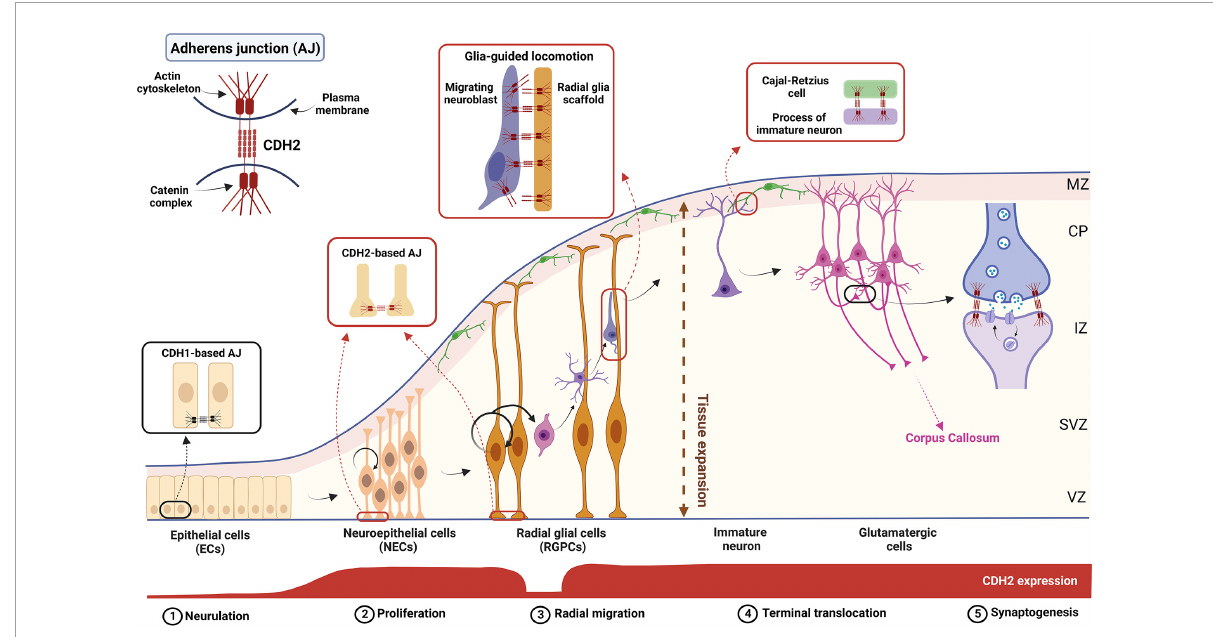
FIGURE1 The complex role of CDH2 during cortical development. Schematic diagram showing the different stages of cortical development. CDH2-based adherens junctions appear after neurulation and are present in both NECs and RGPCs. After asymmetric cell division in the ventricular zone (VZ), newborn, non-radial glia-fated daughter cells delaminate from the RGPCs and undergo radial glia-guided locomotion through the subventricular and intermediate zones (SVZ and IZ, respectively) utilizing CDH2 connections. Once the immature neuron reaches the cortical plate (CP), CDH2 connections between the leading process and a Cajal-Retzius cell in the marginal zone (MZ) are formed which helps to reach and maintain the neuron’s final position in the cortical plate. Further on, during synaptogenesis homophilic CDH2 binding help neuronal outgrowth and synaptogenesis to build up the proper cortical circuits. Figure was created using Biorender.com.